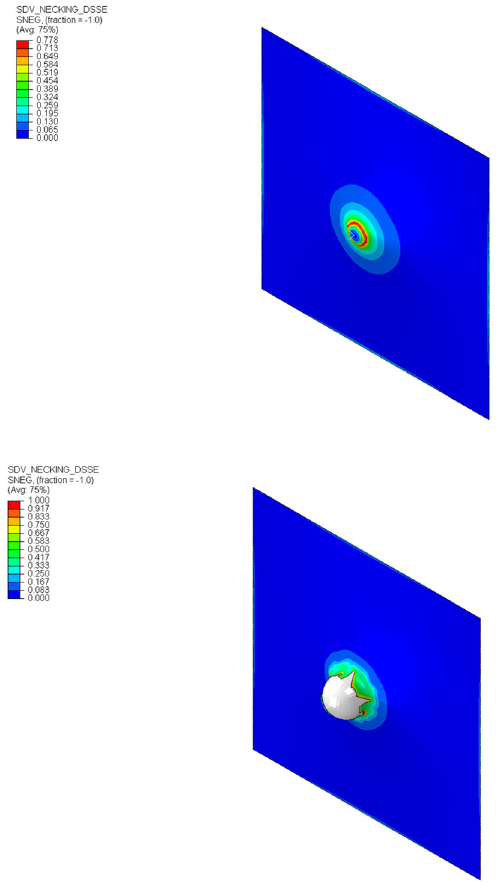
Figure 2. Localized necking indicator plots before and after fracture initiation.